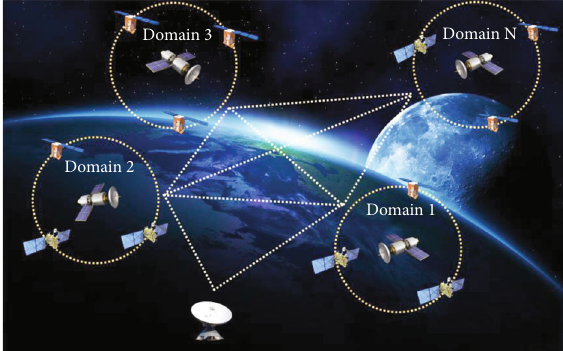
Figure 2: The architecture of decentralized satellite